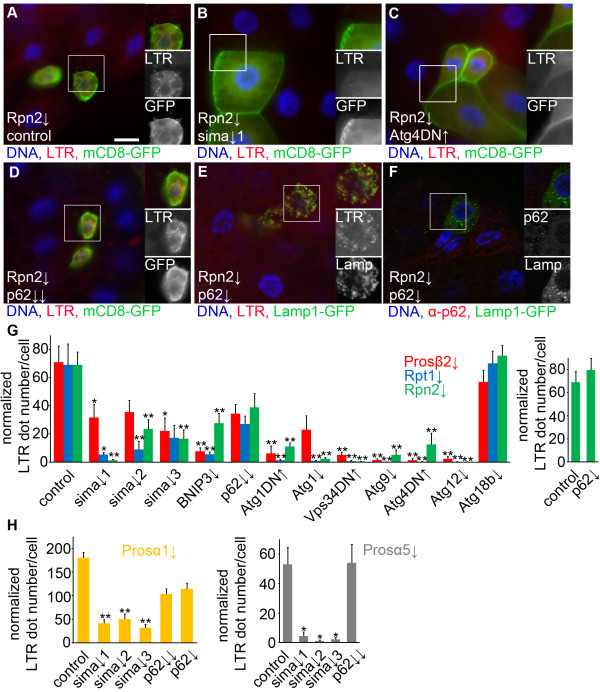
Proteasome inactivation-induced autophagy requires Atg genes and sima/HIF-1α. A) Depletion of Rpn2 increases punctate LTR staining in larval fat body cell clones in fed animals, marked by membrane-associated mCD8-GFP. B) Simultaneous silencing of Rpn2 and sima results in a block of punctate LTR staining. C) Overexpression of dominant-negative (DN) Atg4 inhibits LTR dot formation in Rpn2 RNAi cells. D, E) Simultaneous silencing of Rpn2 and p62 using two independent RNAi lines combined (D) or a third independent single p62 RNAi line (E) does not inhibit punctate LTR staining in larval fat body cell clones in fed animals. F) Depletion of p62 blocks aggregate formation in Rpn2 RNAi cells. G) Statistical evaluation of punctate staining in Rpn2, Rpt1 and Prosβ2 knockdown cells. Depletion of sima using 3 independent RNAi transgenes, silencing of BNIP3, Atg1, Atg9, Atg12, or overexpression of dominant-negative Atg1, Vps34, Atg4 inhibits proteasome inhibition-induced autophagy. Depletion of p62 or Atg18b (which is dispensable for starvation-induced autophagy and used as a negative control here) does not block the autophagy-inducing effect of proteasome inactivation. Statistically significant differences are marked (Kruskal-Wallis test or ANOVA, n = 5-8 per genotype, * P < 0.05, ** P < 0.01), and error bars denote standard error. H) Similarly, silencing of sima but not p62 attenuates LTR puncta formation in Prosα1 and Prosα5 RNAi cells. Statistically significant differences are marked (Kruskal-Wallis test or ANOVA, n = 5-8 per genotype, * P < 0.05, ** P < 0.01), and error bars denote standard error. Boxed areas in A-F are shown enlarged. Scale bar in A equals 20 μm for A-F.